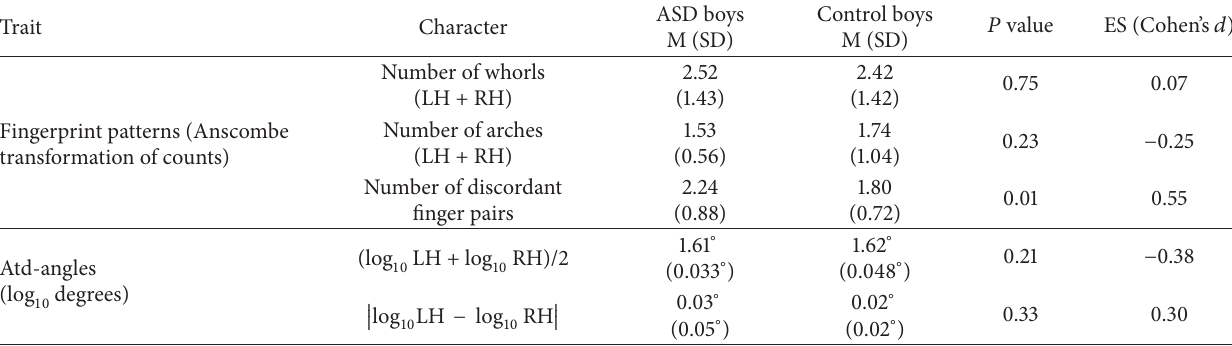
Table 1: Fingerprint pattern counts, number of discordant finger pairs, atd-angles, and fluctuating asymmetry of atd-angles for boys with ASD and typically developing boys.